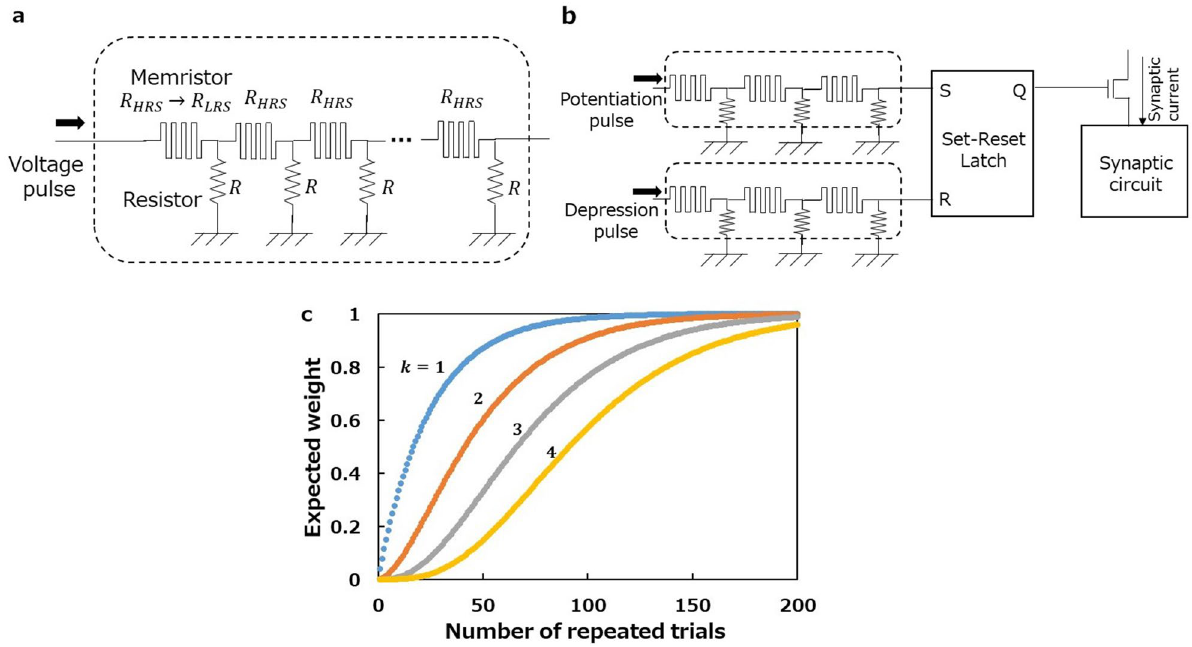
Figure 2. Switching device having serially connected binary memristors to realise the sigmoidal cumulative probability. ( a) Schematics of the device. Connection nodes between two memristors are grounded through a resistor. The resistance R is selected to be sufficiently larger than the LRS resistance ( R LRS ) and sufficiently smaller than the HRS resistance ( R HRS ); R LRS ≪ R ≪ R HRS . This is possible because the ratio of R HRS to R LRS is several orders of magnitude in binary memristors (even if integrated with CMOS transistors 47 ). Voltage pulses are applied to the left terminal, inducing SETs in memristors serially from left to right. To initialise the device, all the memristors should be RESET in parallel in a deterministic fashion. Therefore, a switching device should be designed with multiplexers so that each memristor can be accessed independently for RESET; for clarity, these are not illustrated here. ( b) Schematics of the binary synapse using a pair of switching devices